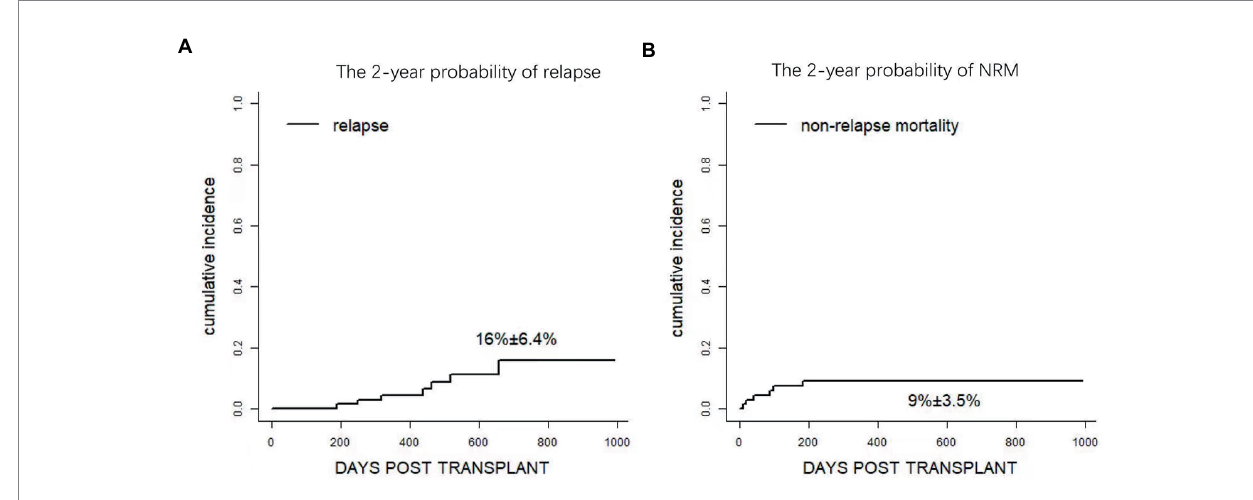
FIGURE 5 Clinical outcomes after Haplo-PBSCT. (A) The 2-year probability of relapse. (B) The 1 year probability of non-relapse mortality